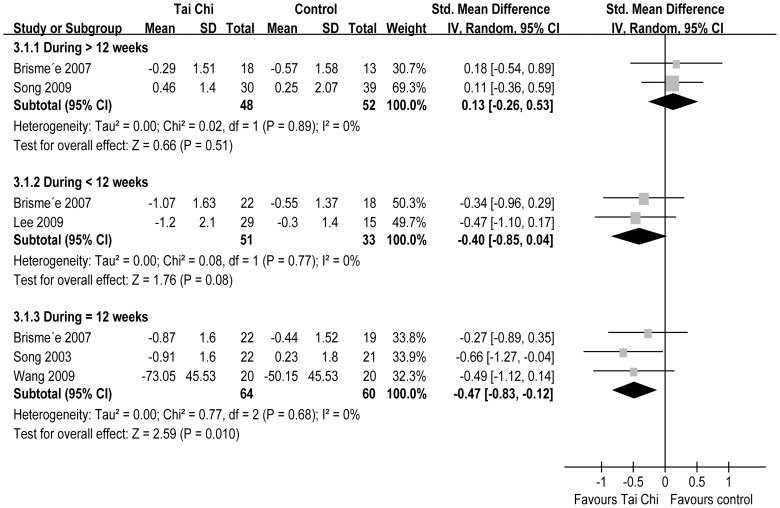
A Forest plot of the subgroup analyses of RCTs comparing Tai Chi group with control group for change in stiffness.